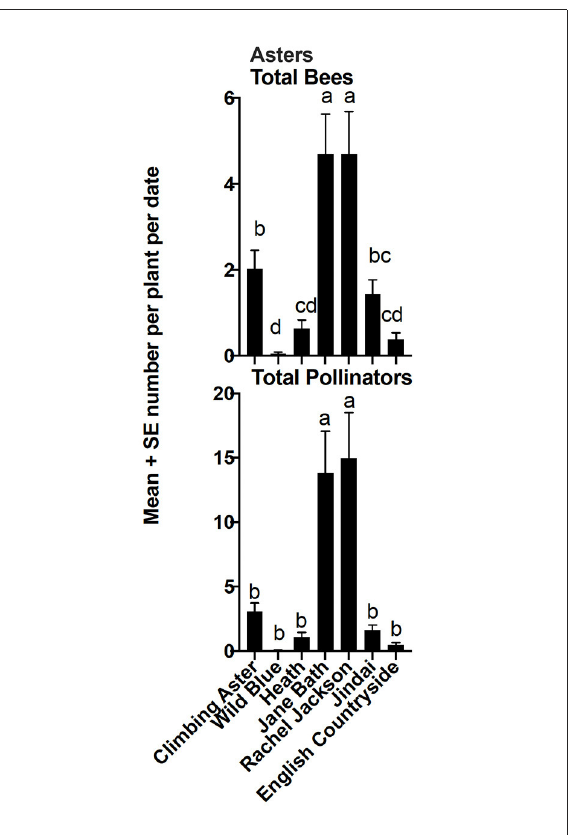
FIGURE6 Mean ± se total bees and total flower visitors (pollinators) comparison among aster cultivars in a 2-year study in central Georgia, USA. The superscript alphabets means with the same letters are not significantly different, p >